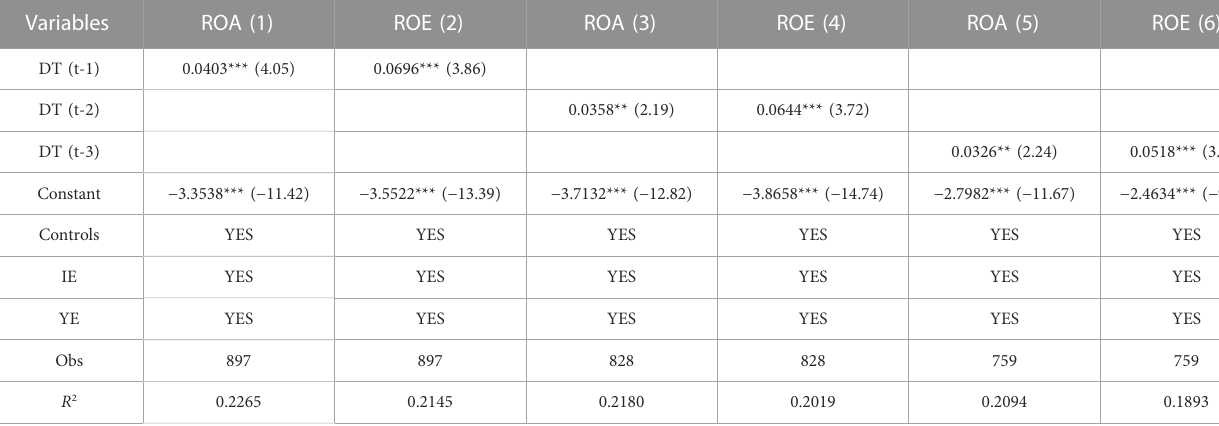
TABLE 5 Robust check: Extending observation window.